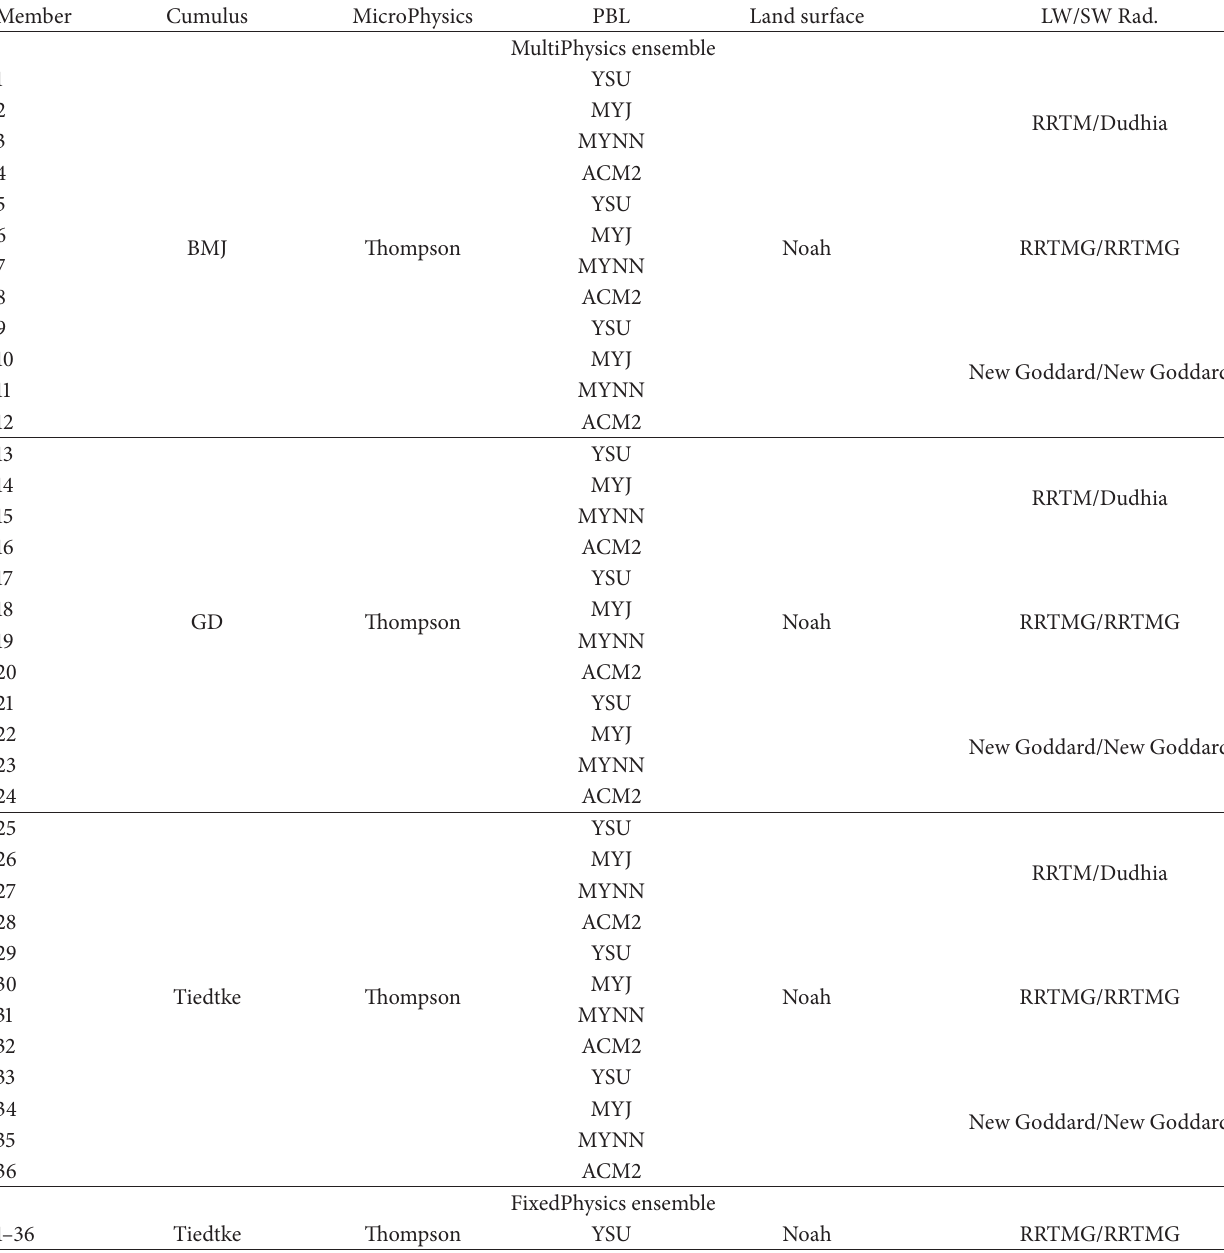
Table 1: Physics options for the MultiPhysics and FixedPhysics WRF mesoscale ensemble